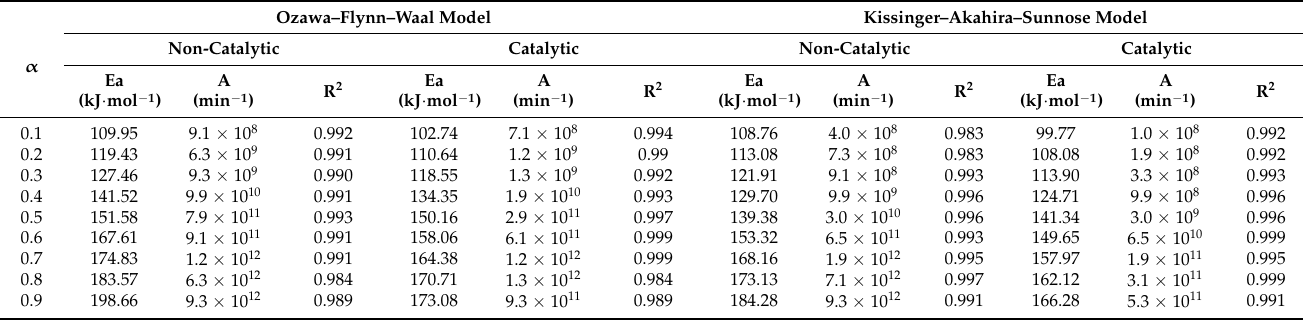
Table 1. Calculated kinetic parameters for PP degradation by the OFW and KAS